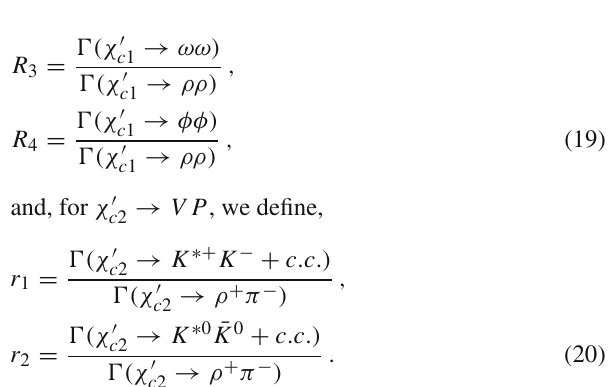
Fig. 7 The α -dependence of the ratios defined in Eq. (20) with m χ (cid:2) 3 . 930